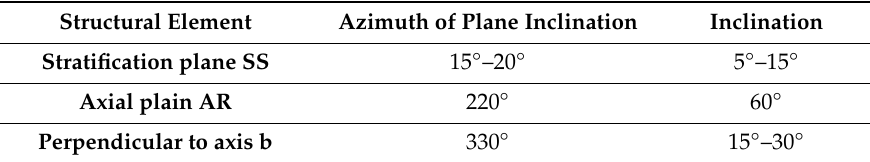
Table 1. Summary of measured rock mass structural